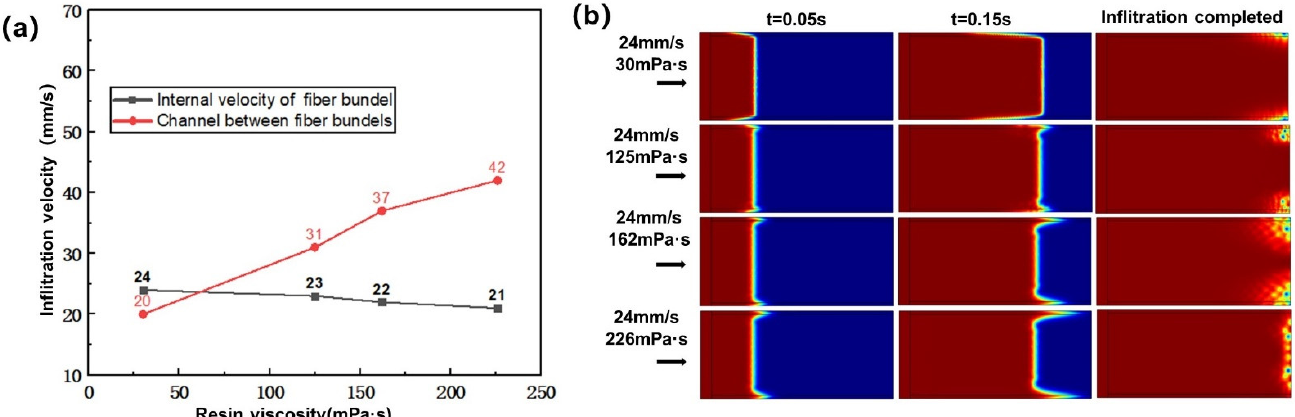
Figure 9. ( a ) Influence of resin viscosity on flow velocity. ( b ) Influence of resin viscosity on flow front.